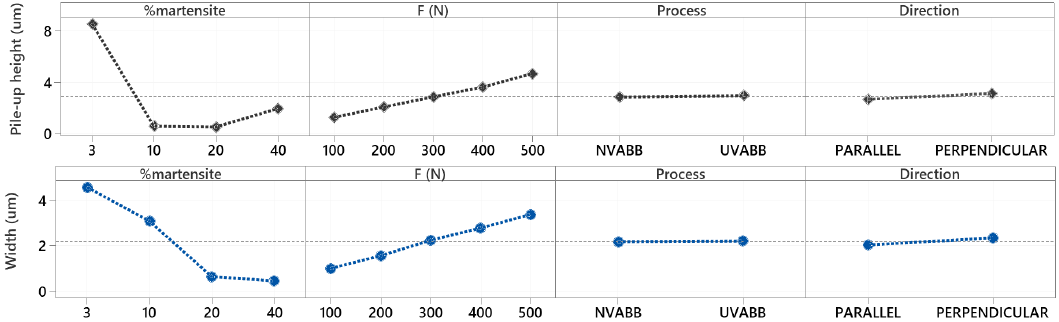
Figure 3. Mean effects of each factor on the imprint pile-up height ( top ) and width ( bottom ) executed through